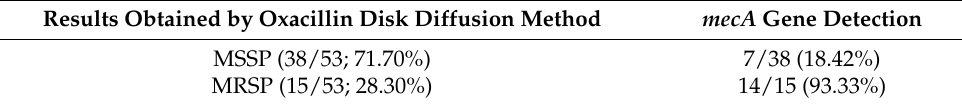
Table 1. Comparison of methicillin susceptibility obtained by the oxacillin disk diffusion method and mecA gene